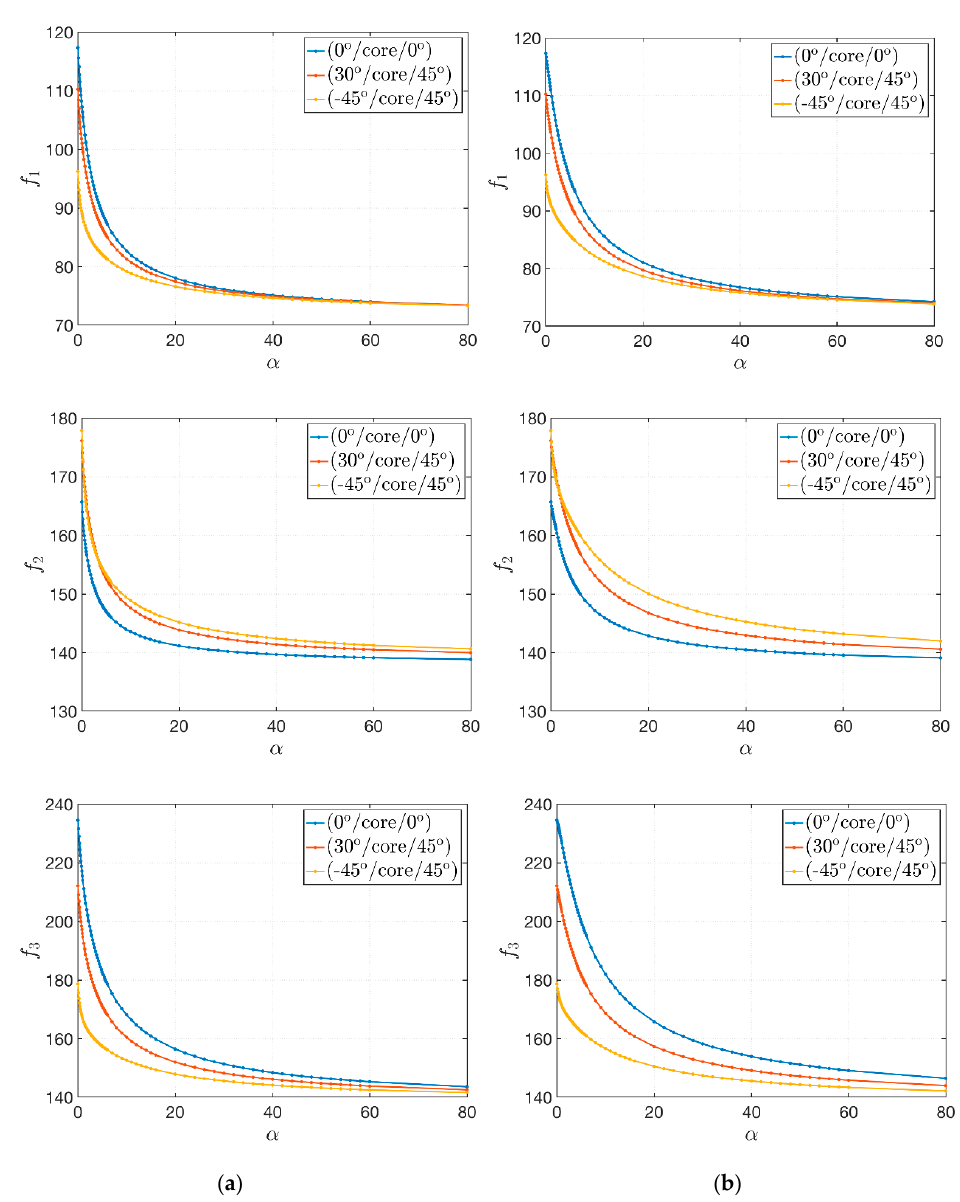
Figure 7. Variation of the first three natural frequencies f 1 , f 2 , f 3 [Hz] for sandwich plates with a damaged soft-core due to an increasing value of the exponent α of the through-the-thickness distribution of the fiber volume fraction, for two different schemes: ( a ) Scheme 2; ( b ) Scheme 3. The geometry of the sandwich plate is kept constant and three laminations schemes are considered: (0°/core/0°), (30°/core/45°) and ( − 45°/core/45°). A damaged core is modeled by setting